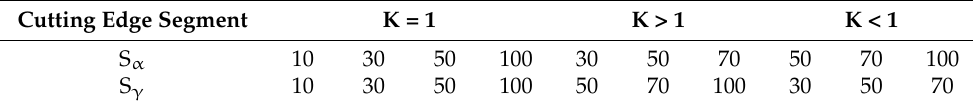
Figure 3. Experimental setup for turning investigations. Table 1. Cutting edge